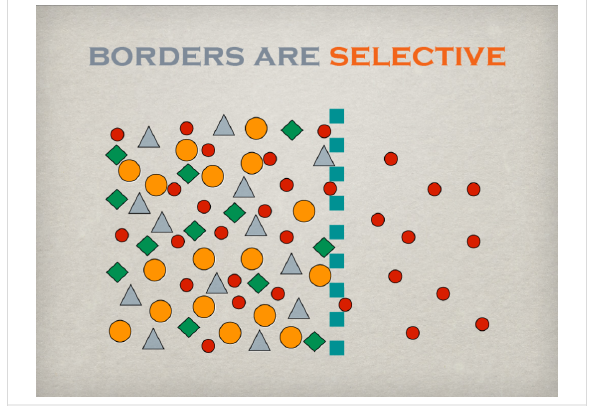
Figure 6: The selective permeability is another main function of